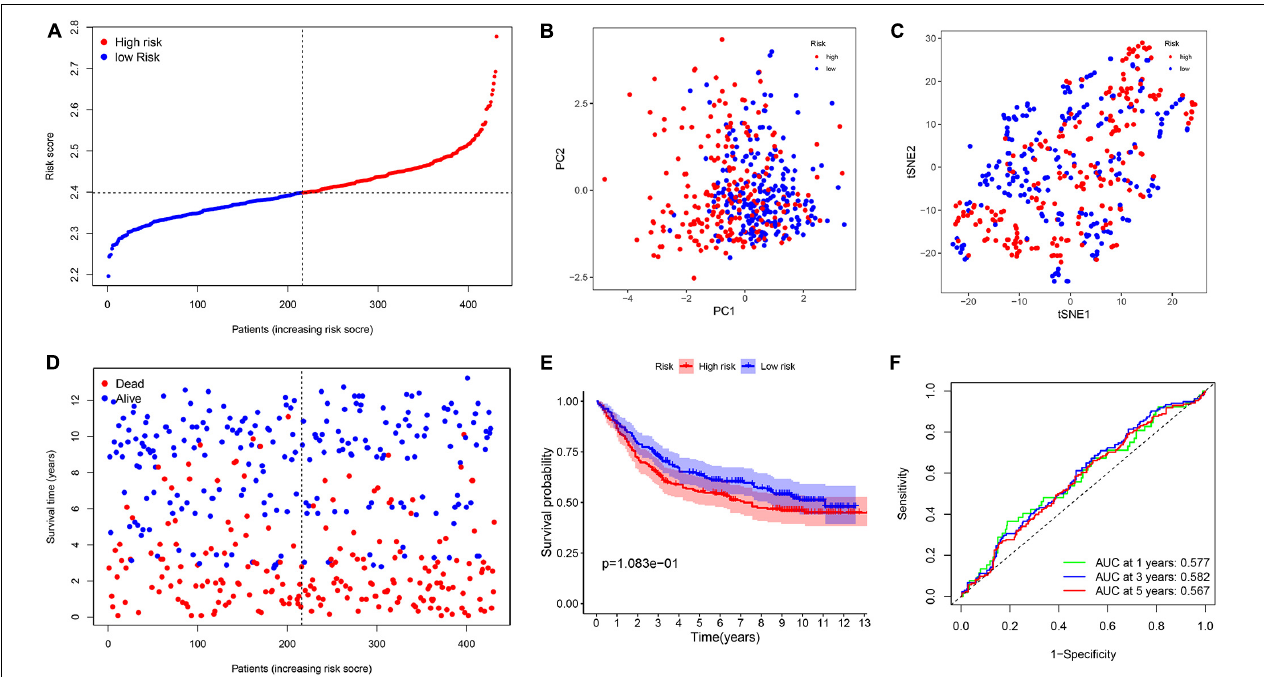
FIGURE 7 | Validation of the prognostic model in the Gene Expression Omnibus (GEO) cohort. (A) The distribution of risk score. (B) PCA analysis. (C) T-SNE plot. (D) The distribution of OS. (E) The Kaplan–Meier survival analysis between the two groups. (F) AUC in ROC analysis for risk signature at 1-, 3-, and 5-year survival